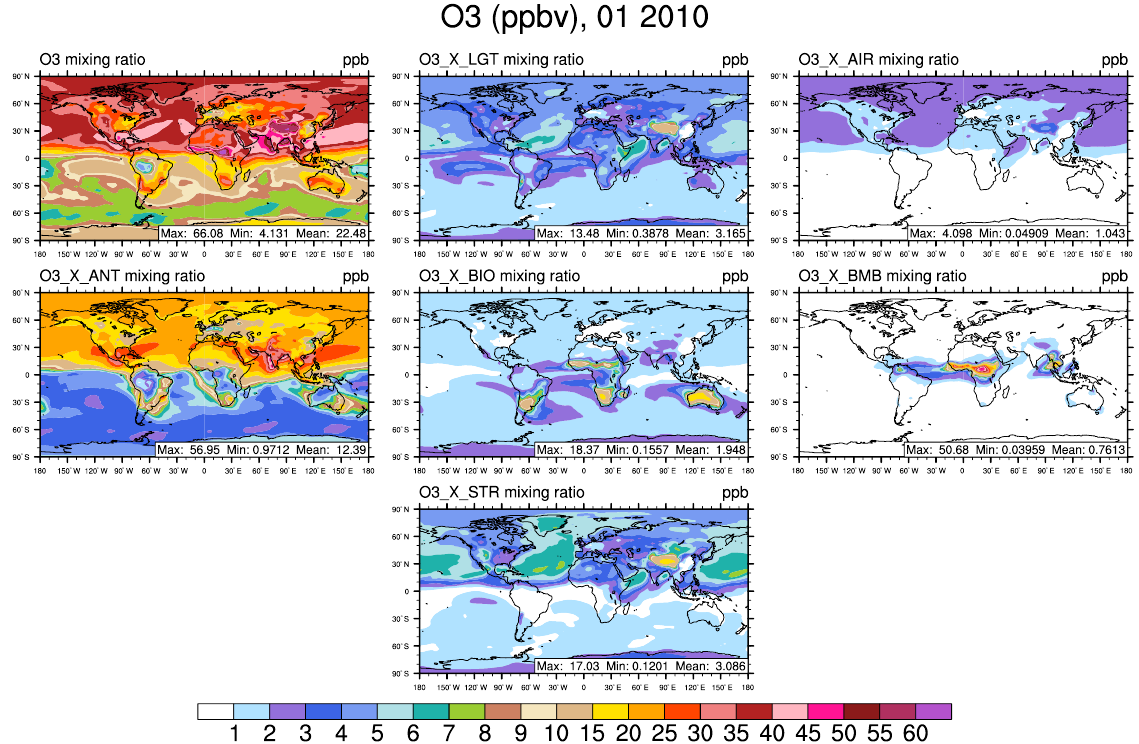
Figure 1. Surface ozone in January from the NO x -tagging run. Total surface ozone is shown in the top left panel. Other panels show the contribution to surface ozone due to NO x precursors emitted by lightning (LGT), aircraft (AIR), anthropogenic sources (ANT), biogenic sources (BIO), biomass burning (BMB), and transport from the stratosphere